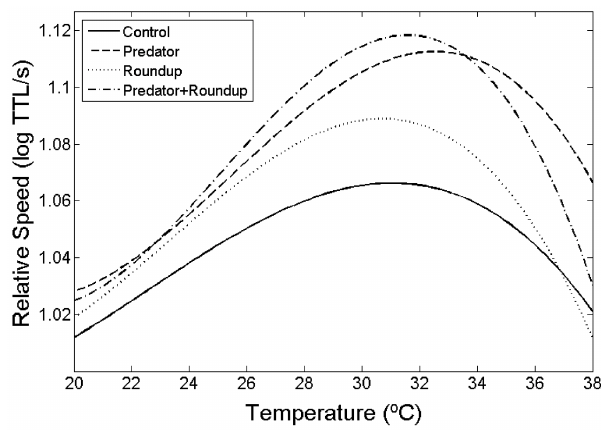
Figure 2. Overall shape of the thermal performance curves for each of the four induction treatments. Each treatment is represented by a thermal performance curve for tadpole swimming speed: control - solid line, predator - dashed line, Roundup - dotted line and predator + Roundup - dash-dot line.